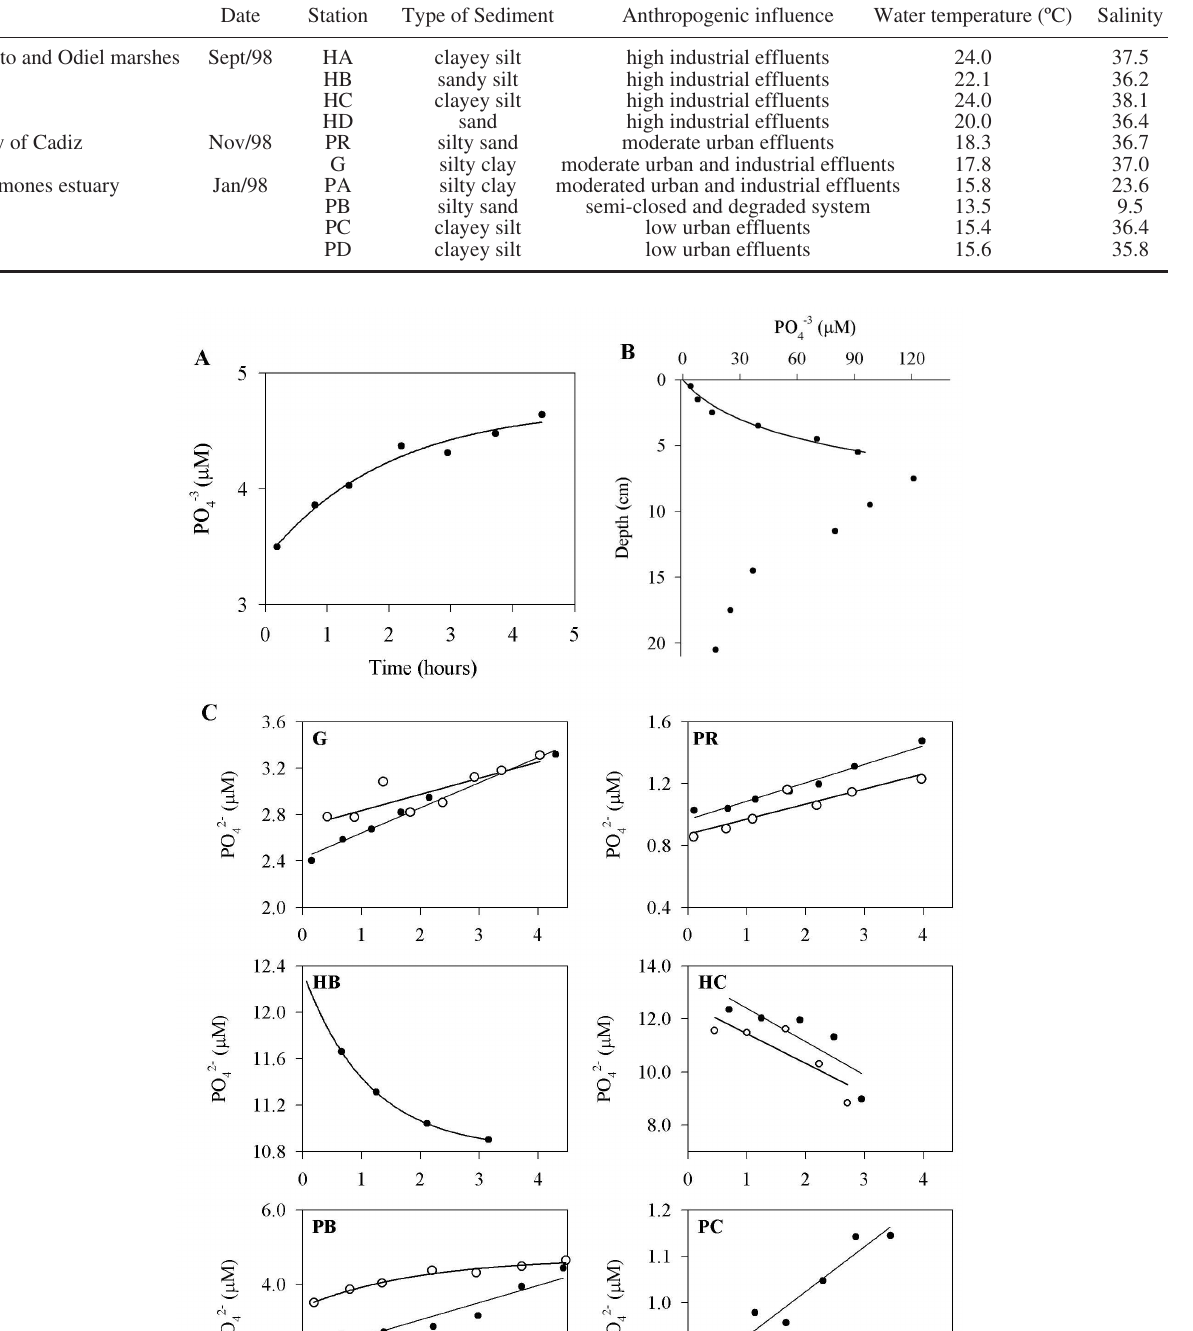
Table 1. – Characterization of the 10 sampling stations in the Gulf of